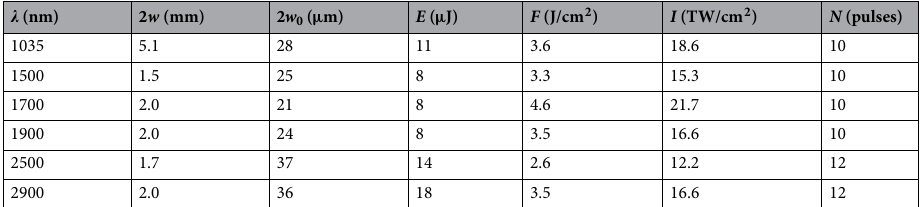
2 . The red arrow indicates polarization direction of the incident